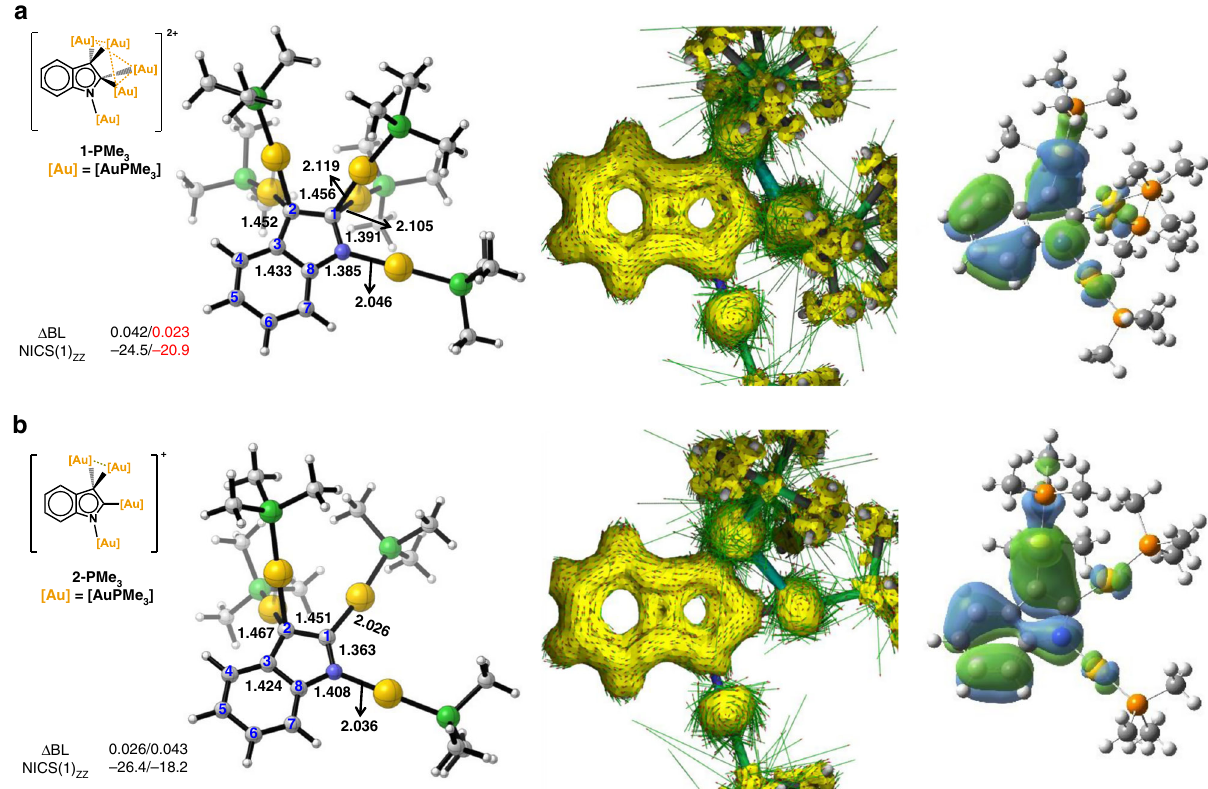
Fig. 4 Theoretical calculation studies on 1-PMe 3 and 2-PMe 3 . Calculated models and AICD plots (isovalue: 0.03) of the π orbitals contribution and HOMOs (isovalue: 0.02) of a 1-PMe 3 and b 2-PMe 3 . The NICS(1) zz values given before and after the ‘ / ’ are those computed at 1 Å above the geometrical centers of 6MR and 5MR,